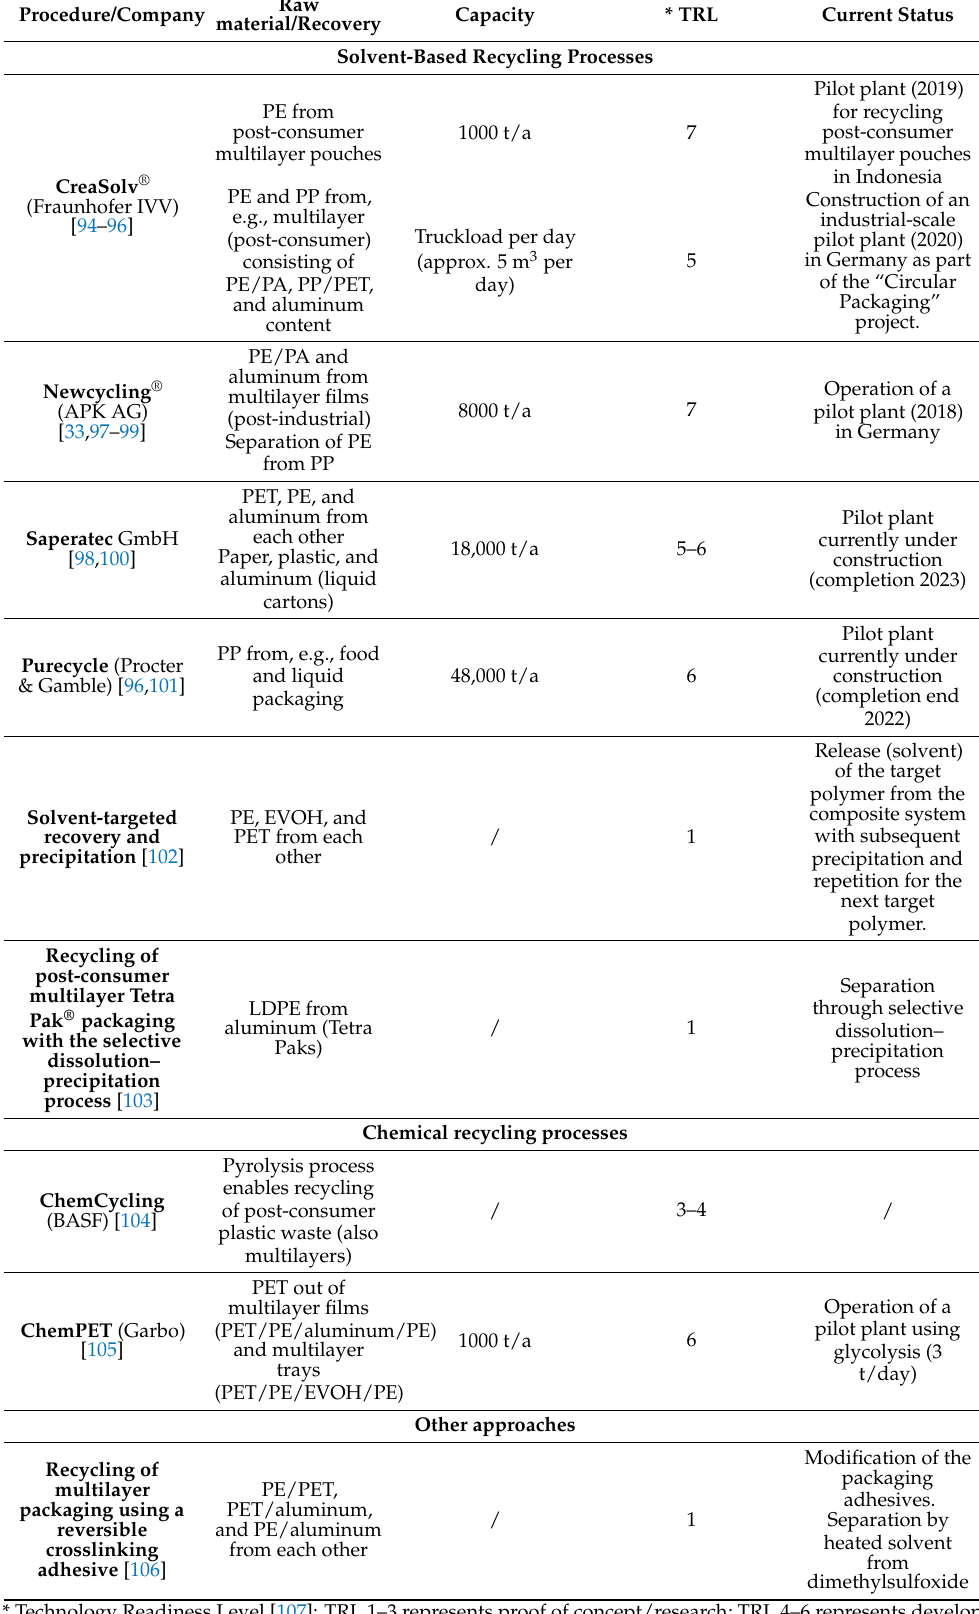
Table 3. Methods for the treatment of multilayers and their degrees of